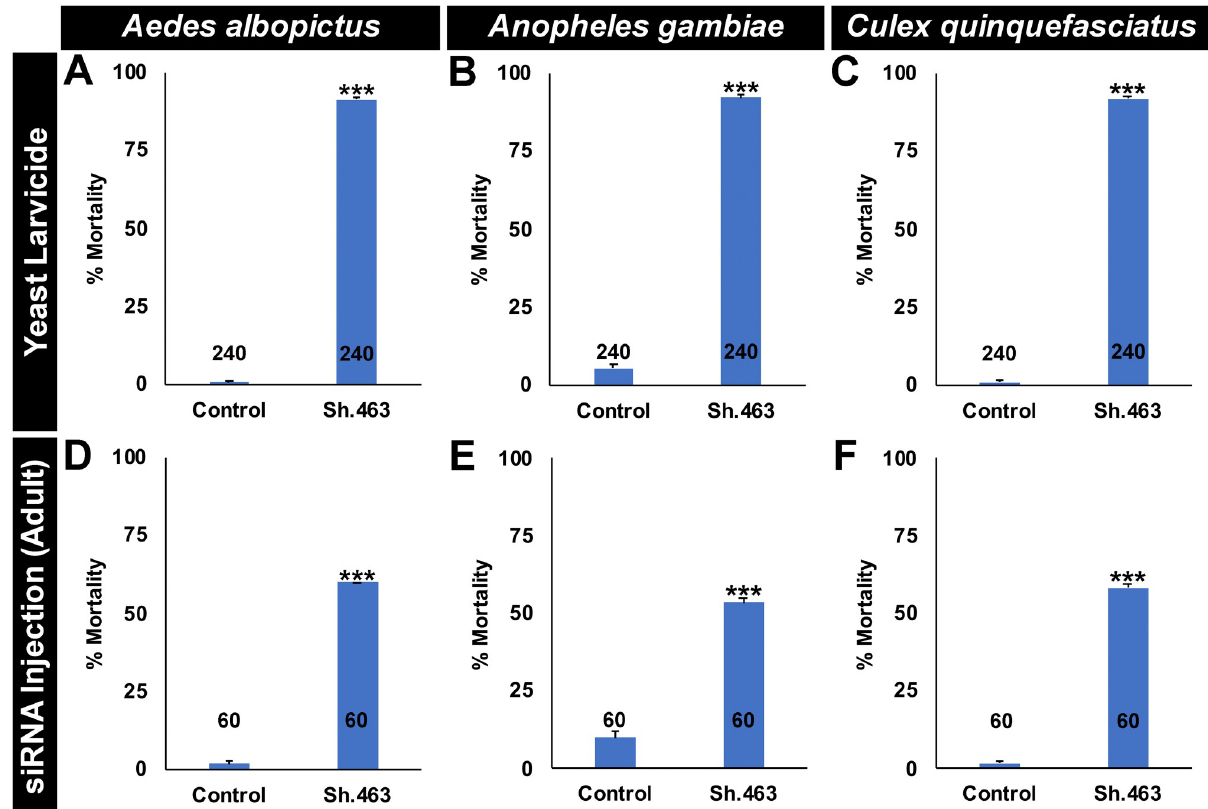
Fig 6. Sh.463 is a broad-range mosquito pesticide. Consumption of Sh.463 IRP yeast (A-C) induces high levels of mortality in A . albopictus (A), A . gambiae (B), and C . quinquefasciatus (C) larvae. Injection of Sh.463 siRNA induces mortality in A . albopictus (D), A . gambiae (E), and C . quinquefasciatus (F) adult females (see Methods for dosage information). The data are represented as mean mosquito mortality, and error bars denote SEM. ��� = P < 0.001 when compared with control-treated mosquitoes.